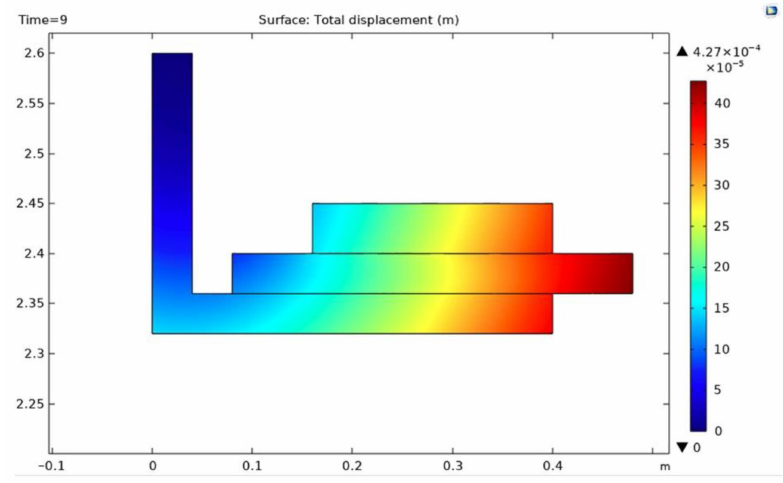
Figure 12. Cross-section of the deformation at t = 9 s.